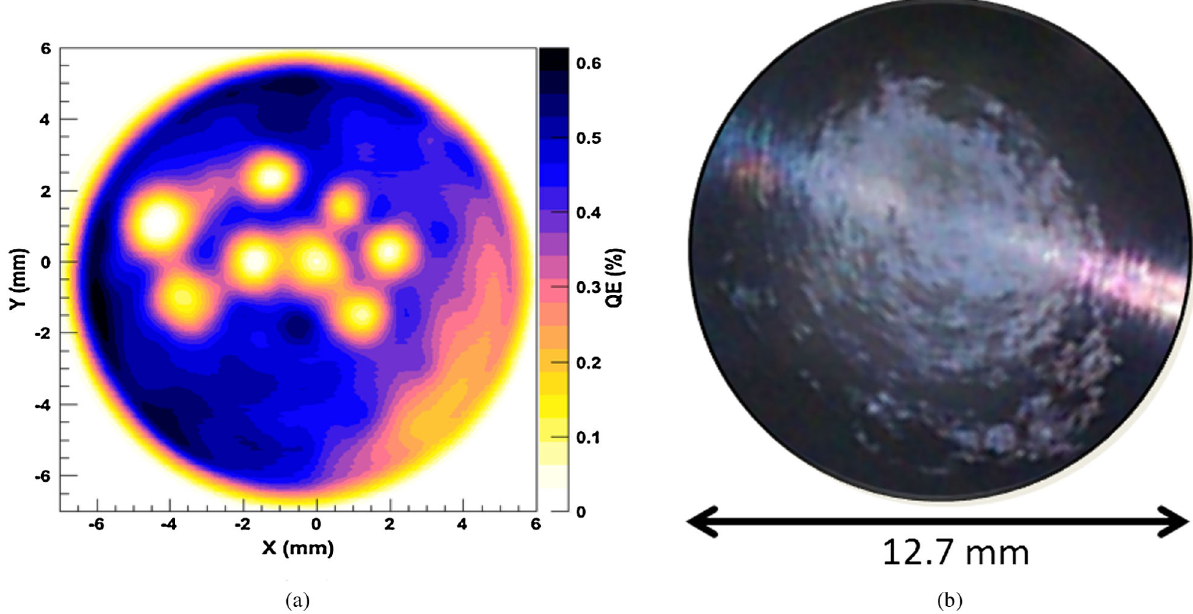
FIG. 19. (a) QE scan and (b) a photograph of photocathode #2 prior to transfer to the